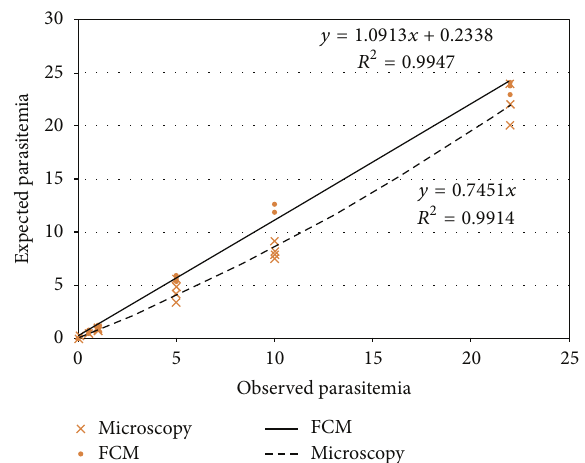
Figure 3: Correlation between FACS and Giemsa stained micro- scopic determinations of parasitaemia with artificially diluted sam- ples. The lines represented the linear regression whose statistical parameters were shown in the inset. Each symbol represented FACS measurement of parasitemia (in 10,000 RBCs)and its corresponding microscopic manual count. Plotted parasitemias ranged from 0.01% to 22.0% (expected